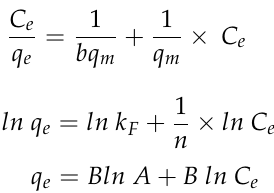
Table 2. Isotherm modeling parameters for BG adsorption on GO-PANI.